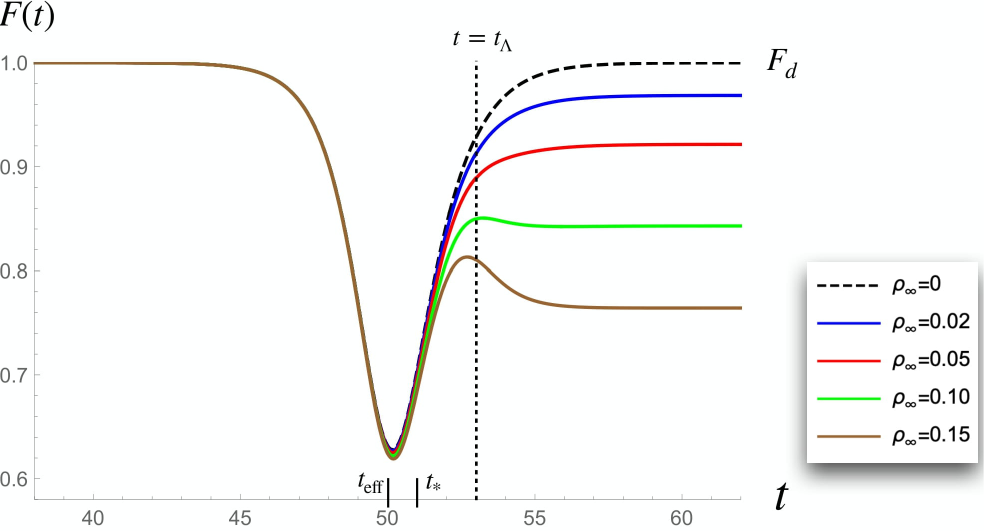
Figure 6 . A long-tailed correction can change the asymptotic behavior of the extremally chaotic OTOC. This is a plot of the (regularized) extremally chaotic OTOC with long-tailed corrections ( t ) + δF ( t ) for various values of ρ . For the plot, we have chosen β = 2 π, F F reg ∞ ext 50 , (cid:15) = 0 . 5 , t = 51 and t = 53 , where t is the time scale at which long-tailed corrections start to ∗ Λ Λ β become important. At early times t , the OTOC remains Λ − t (cid:29) 2 π